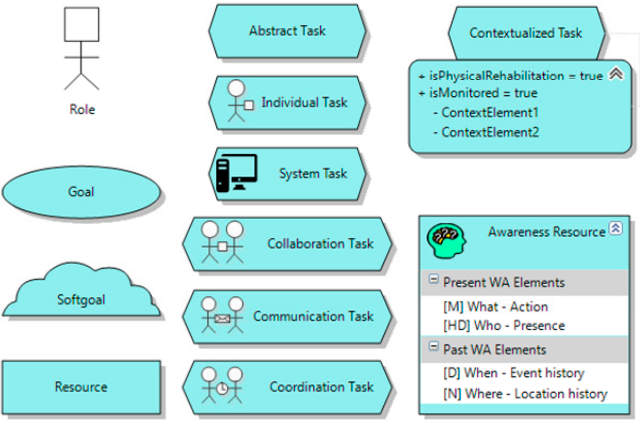
Figure 3. Elements of the bio-inspired task model.